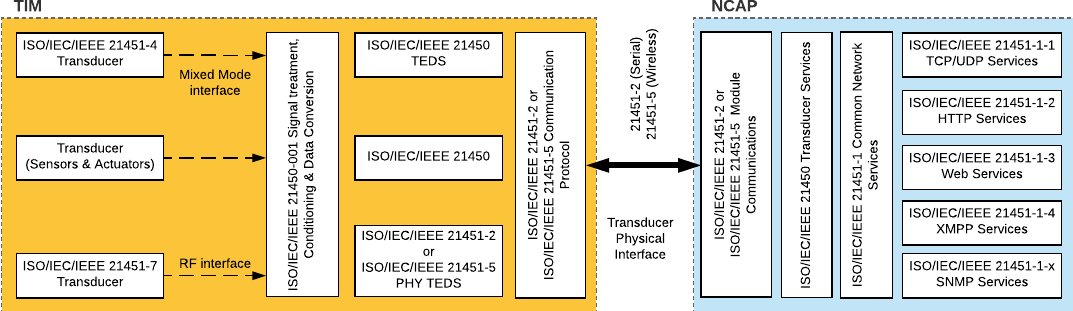
Figure 1. The IEEE 21451 family of standards and their